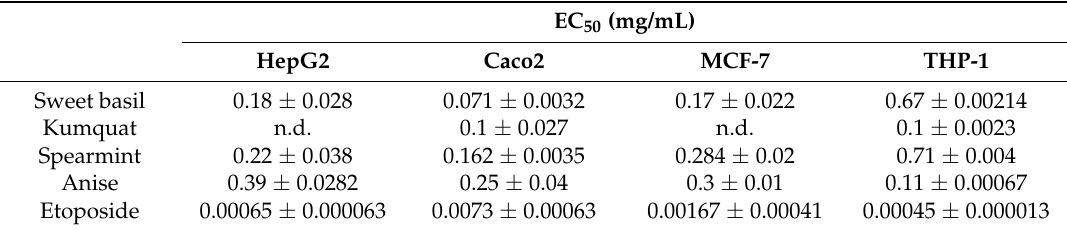
Table 7. EC 50 values of the essential oils against the different human cancer cell lines tested. Etoposide was used as a positive control.